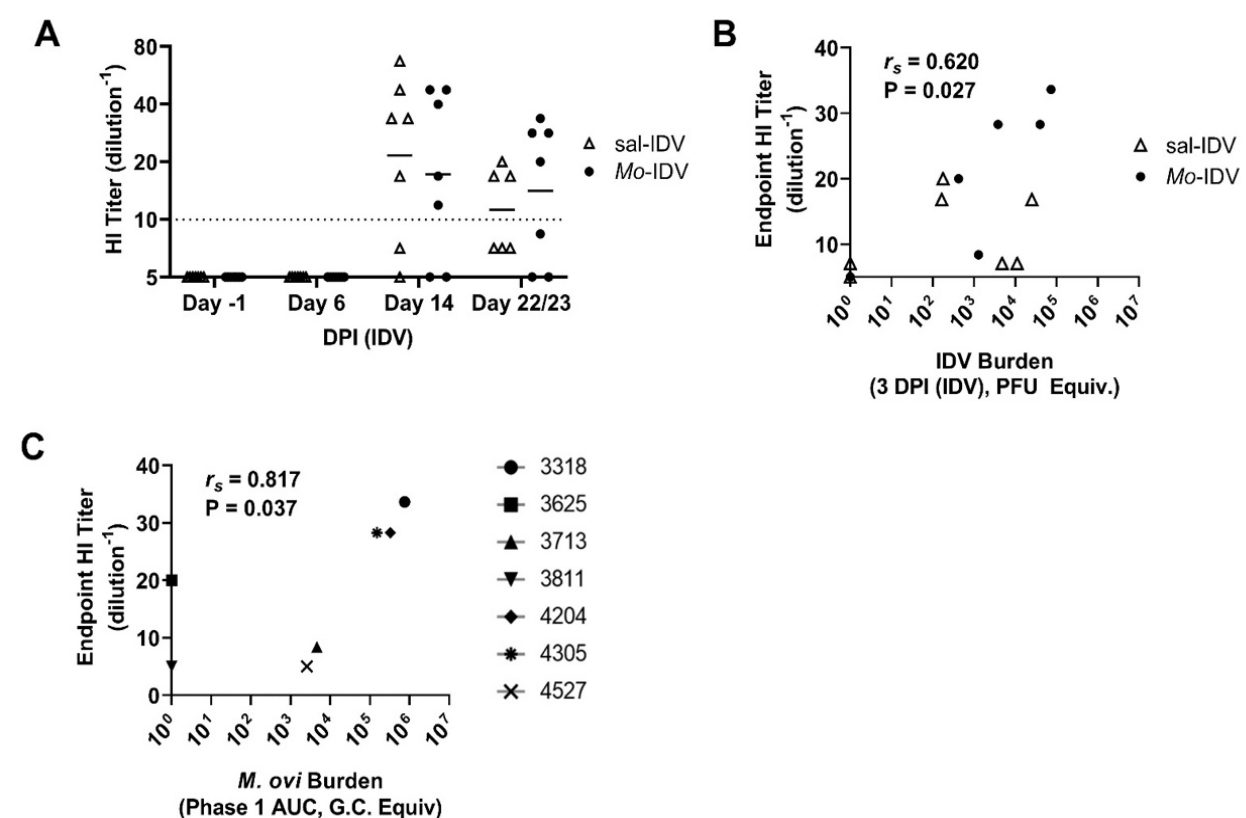
Figure 4. IDV antibody response correlates to prior M. ovipneumoniae burden and early-IDV-infection viral load. ( A ) Neutralizing antibody titer by HI assay. ( B , C ) Correlations between HI titer and ( B ) viral burden at 3 days post-IDV or ( C ) total M. ovipneumoniae burden during phase 1 (Phase 1 AUC). AUC: area under the curve; r s : Spearman correlation coefficient; P: p -value. Horizontal line denotes HI cutoff value (10).